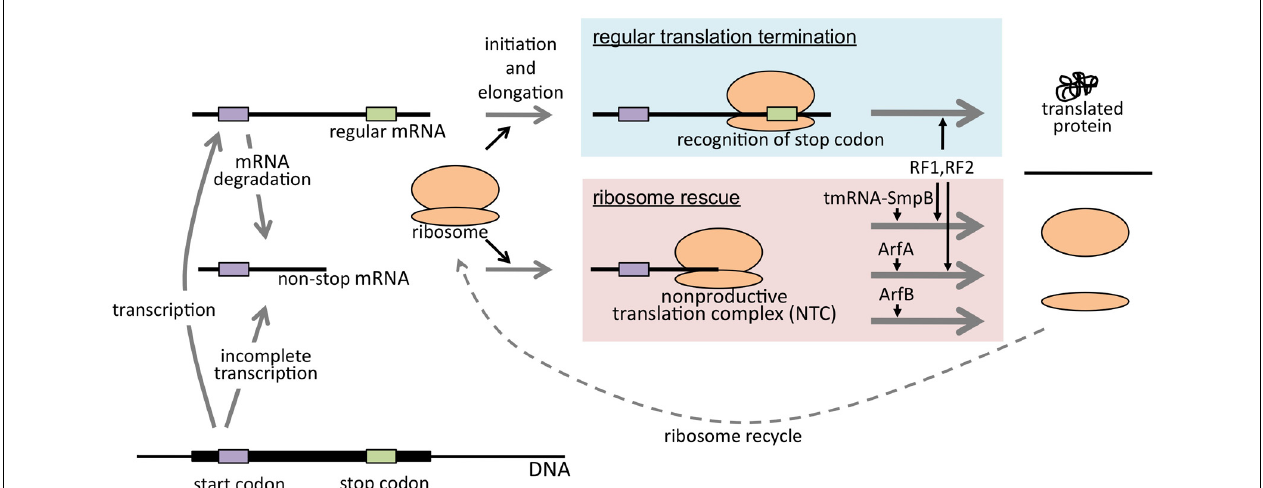
FIGURE 3 | Biological significance of ribosome rescue. Non-stop mRNA is produced either by immature transcription or degradation of mature mRNA and causes NTC formation when translated. E. coli cell is equipped with at